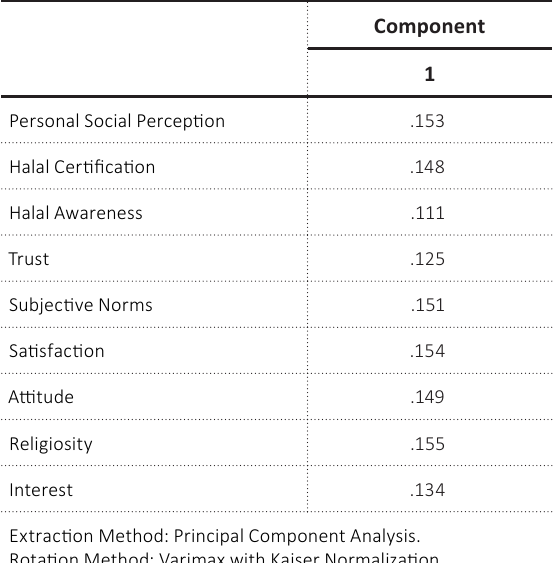
Table 7. Component score coefficient